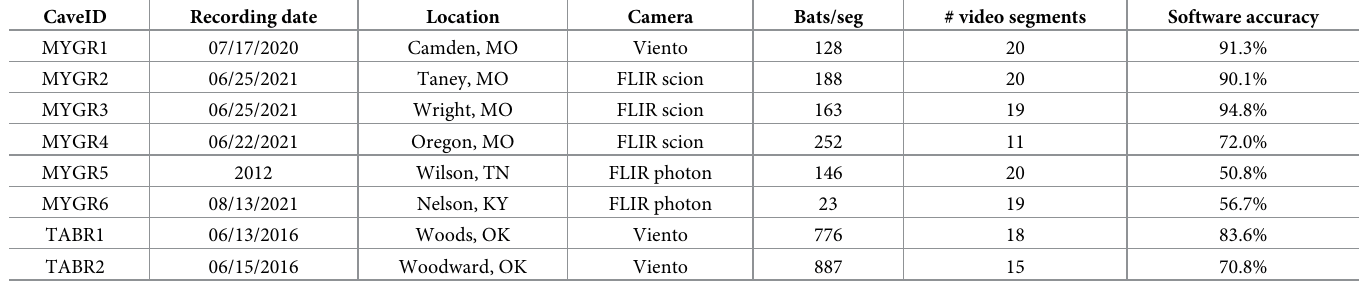
Table 2. Recording date (month/day/year), location (county, state), camera type, average number of bats per 900-frame segment, number of video segments included in the analysis, and overall software accuracy for each of the eight recordings used to evaluate the